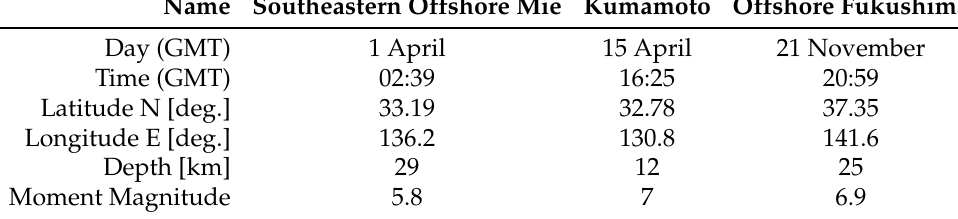
Table 1. Earthquakes of 2016 analyzed